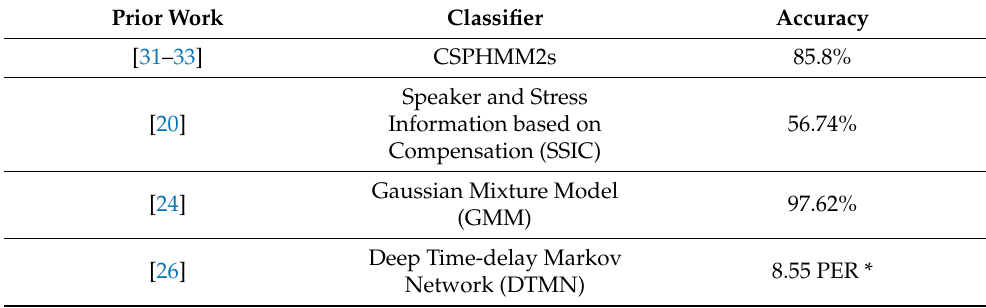
Table 1. Comparison with previous